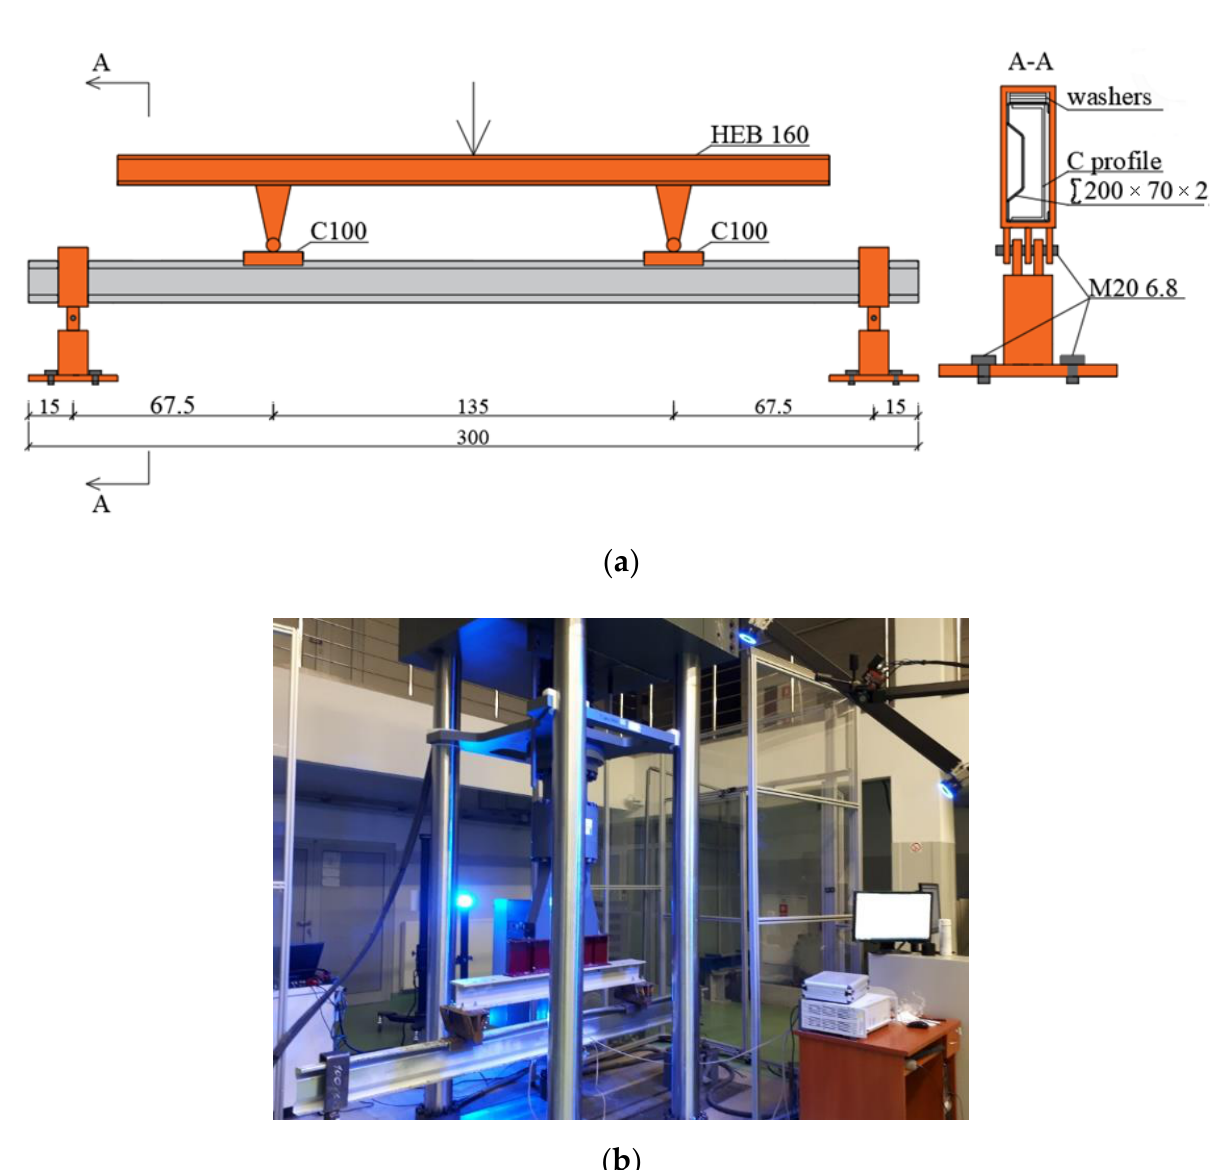
Figure 1. Laboratory stand: ( a ) scheme, and ( b ) photography [2]. The beams were reinforced in three variants, placing the tape on the upper and bottom flange or on the web. In the case of beams reinforced with CFRP tapes, three beams were tested for each reinforcement location, and in the case of beams reinforced with steel tapes, two beams for each reinforcement location were tested. To simplify the comparison of the laboratory results of the displacement and strain of beams reinforced with steel or CFRP tapes, it was decided to determine the arithmetic mean value of the results obtained by the samples reinforced in the same way. Therefore, the designations of the beams were unified. For example, the B1R and B2R beams are reference beams, without reinforcement, and the arithmetic mean of the displacement and strain values obtained for these beams are referred to as BR (Figure 2). The same procedure was applied to all other tested beams. It means that BG is the designation of the arithmetic mean value determined for the group of beams reinforced with CFRP tape placed on the upper flange, BS is the group of beams reinforced with CFRP tape on the web and BD is the designation of beams reinforced with CFRP tape placed on the bottom flange. The groups of beams reinforced with steel tape were named similarly (BGs—steel tape placed on the upper flange, BGs—on the